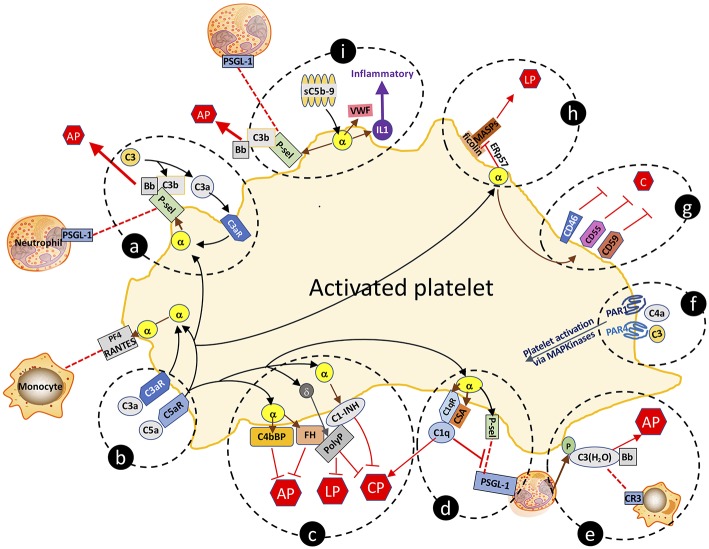
Complement-platelet interactions that can facilitate an inflammatory response that favors atheroma formation. Selected interactions between complement and platelets, as described in the manuscript, are highlighted. (a,b) C3a and C5a bind to their cognate receptors to trigger release of factors from α-granules. P-selectin localizes to the platelet surface and is a receptor for leukocyte expressed PSGL-1 and for C3b, the latter which allows for initiation of the AP and amplification of C3a-triggered platelet activation. (c) Complement activation on the platelet surface is dampened by α-granule release of cofactors C4bBP, FH and C1-INH, and δ-granule release of the anti-complement, prothrombotic polyphosphate. Polyphosphate binds to FH and C1-INH, and downregulates complement activation via the CP and the terminal pathway. (d) By binding to C1qR, C1q also triggers α-granule release of P-selectin and chondroitin sulfate (CSA), the latter which enhances the C1q-C1qR interaction, initiating the CP but negatively regulates leukoctye recruitment by interfering with P-selectin-PSGL-1 interactions. (e) Neutrophil-released properdin (P) stabilizes the convertases and is also a receptor for C3(H2O) which complexes with Bb to form the AP C3-convertase, and is a ligand for leukocyte-expressed CR3, thereby facilitating leukocyte cell migration to the site of inflammation. (f) C4a and C3 can activate platelets via distinct interactions with PAR1 and PAR4. (g) Activated platelets are also protected against complement-mediated destruction by granule release of negative regulators of complement, cell surface expressed CD46, CD55, and CD59. (h) Sublytic C5b-9 (sC5b-9) triggers platelet activation with release of VWF, P-selectin and inflammatory cytokines (e.g., IL1), the latter which further promotes inflammation. (i) Ficolins on the surface of activated platelets are receptors for MASPs which can trigger the LP. Release of the isomerase ERp57 modifies the ficolin to limit its functional capacity to trigger complement. C, complement activation pathways; AP, alternative pathway; LP, lectin pathway; CP, classical pathway; PF4, platelet factor 4; C3aR, C3a receptor; C5aR, C5a receptor; C1qR, C1q receptor; P-sel, P-selectin; PSGL-1, P-selectin glycoprotein ligand-1; sC5b-9, sublytic C5b-9; VWF, von Willebrand factor; α, α-granule; δ, δ-granule; ERp57, endoplasmic reticulum protein 57; PAR, protease activated receptor; P, properdin; CR3, complement receptor 3; PolyP, polyphosphate; IL1, interleukin 1.